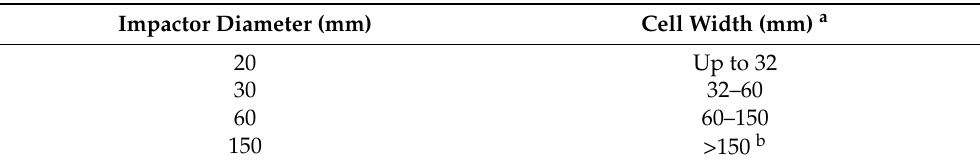
Figure 10. Impactor for crushing prismatic and pouch cell as per SAND2017-6925:2017 [107]. Table 7. Recommended impactor diameter for crushing prismatic and pouch cells as per SAND2017- 6925:2017